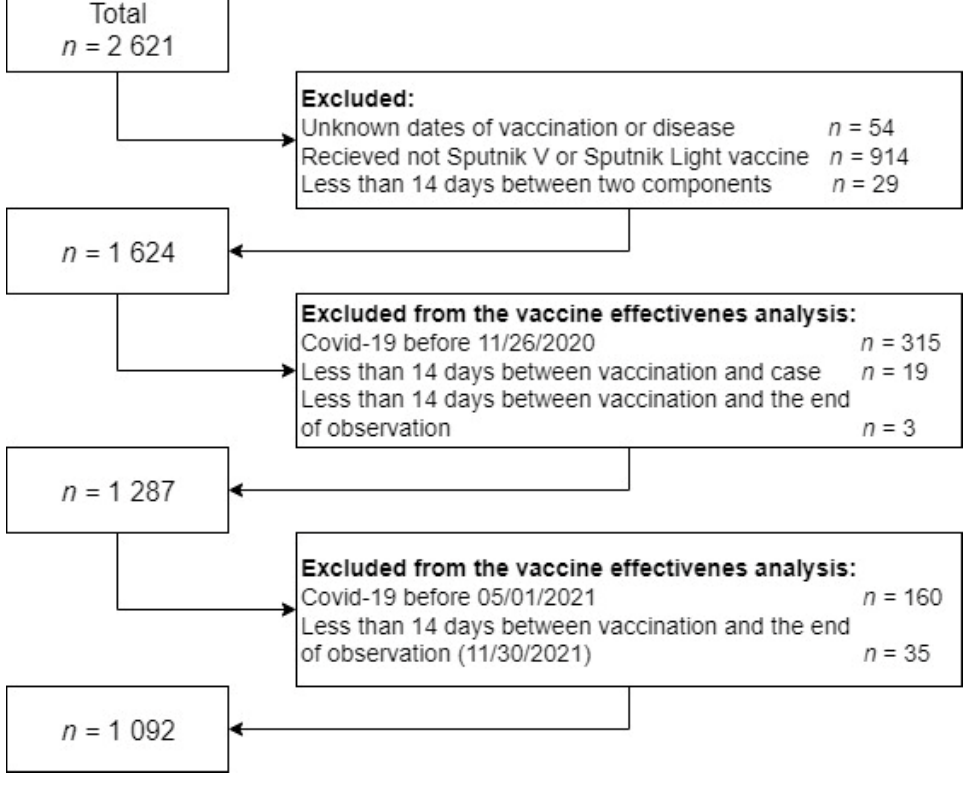
Figure 1. Database in preparation for the analysis.